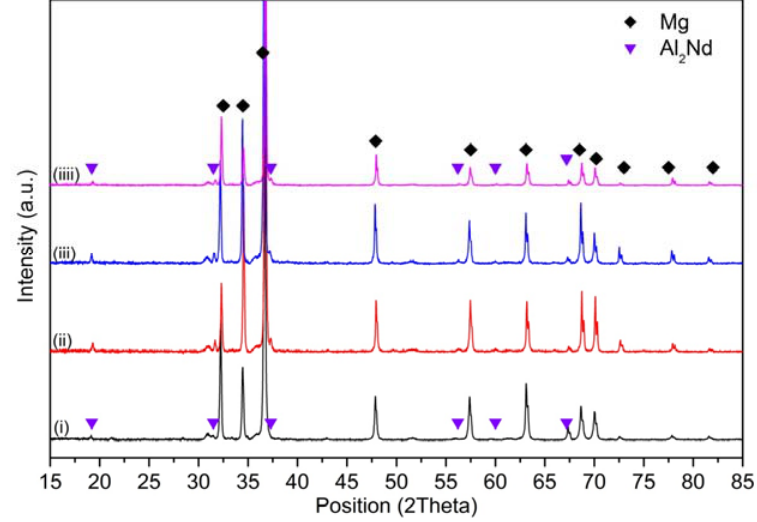
Figure 17. X-ray diffraction patterns of EL21–2 wt.% AlN: (i) as-cast; and solutionized at: (ii) 520 ◦ C; Figure 17. X ‐ ray diffraction patterns of EL21–2 wt.% AlN: (i) as ‐ cast; and solutionized at: (ii) 520 °C; (iii) 550 ◦ C; and (iiii) 580 ◦ C. (iii) 550 °C; and (iiii) 580 °C.